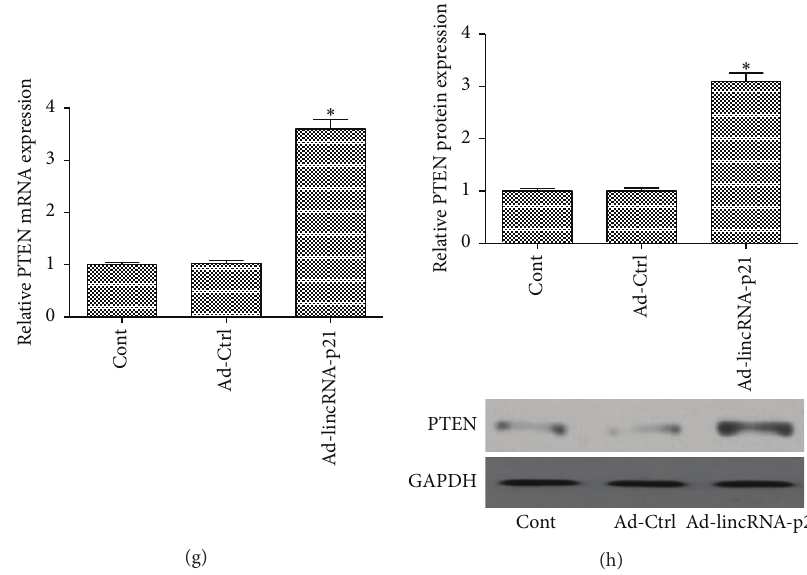
Figure 2: Effects of lincRNA-p21 overexpression on cell proliferation, 𝛼 -SMA, type I collagen, and PTEN in LX-2 cells. Cells were transduced with Ad-lincRNA-p21 for 48 h and treated with PTEN siRNA for additional 48 h. (a) lincRNA-p21 was detected in cells transduced with Ad- lincRNA-p21. Overexpression of lincRNA-p21 suppressed cell proliferation (b), 𝛼 -SMA mRNA (c), 𝛼 -SMA protein (d), Col1A1 mRNA (e), and type I collagen (f), which were almost blocked down by PTEN siRNA. Cell proliferation was assessed by CCK-8 assay. PTEN mRNA (g) and protein (h) expressions were upregulated by Ad-lincRNA-p21. GAPDH was used as internal control. Each value is the mean ± SD of three experiments. ∗ 𝑃 < 0.05 compared with the control and # 𝑃 < 0.05 compared with Ad-lincRNA-p21